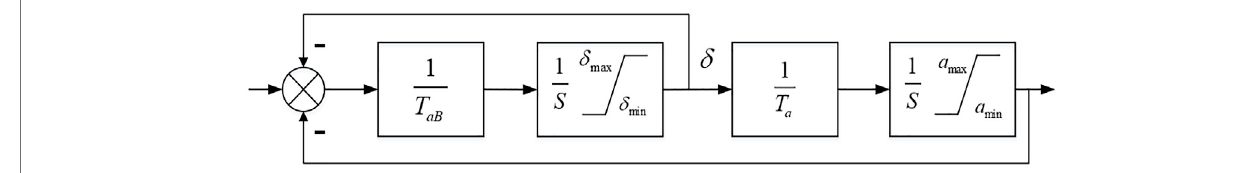
FIGURE 7 | Block diagram of the servo mechanism.